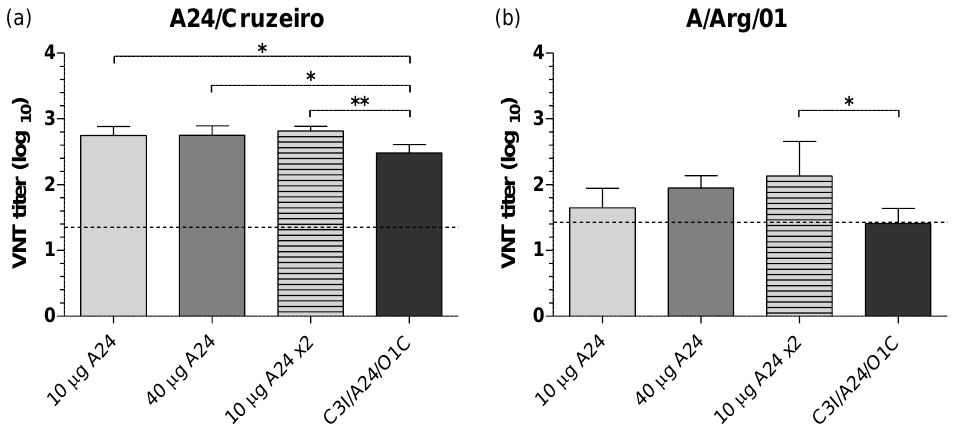
Figure 3. Neutralizing antibodies against FMDV A24/Cruzeiro and A/Arg/01 strains at 30 dpv. Serum neutralizing antibodies against FMDV A24/Cruzeiro ( a ) and A/Arg/01 ( b ) strains were measured by virus neutralization test (VNT) for all vaccinated animals. Results represent the mean of four independent experiments and are expressed as the log 10 of the resulting mean titer in each experimental group at 30 dpv. Bars represent the mean value of each experimental group ± SD. Dotted lines depict VNT titers corresponding to the EPP 75 for A24/Cruzeiro strain (1.35) and A/Arg/01 strain (1.43) in the corresponding charts. Asterisks denote statistical differences between experimental groups (ANOVA) * p ≤ 0.05 and ** p ≤ 0.01.